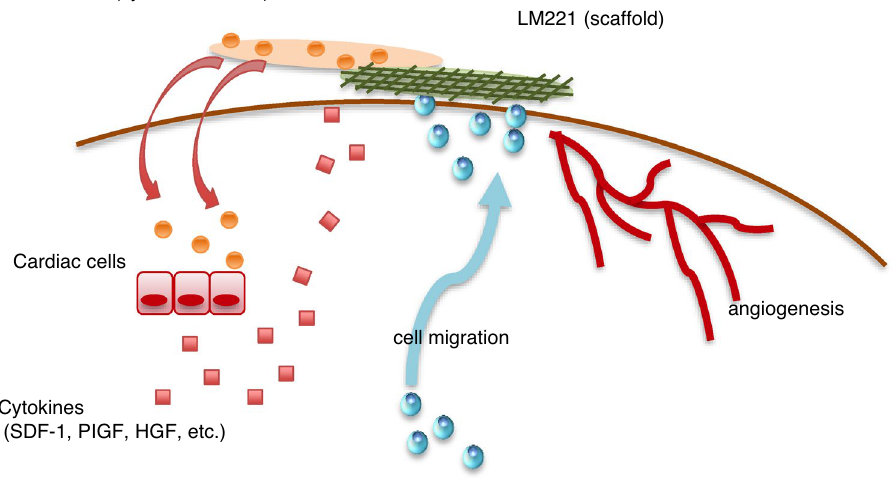
Figure 9. Schematic figure of proposed mechanisms underlying LM221 and ONO1301-administrated treatment of myocardial infarction heart. ONO1301 is linearly released and infiltrated into the cardiac